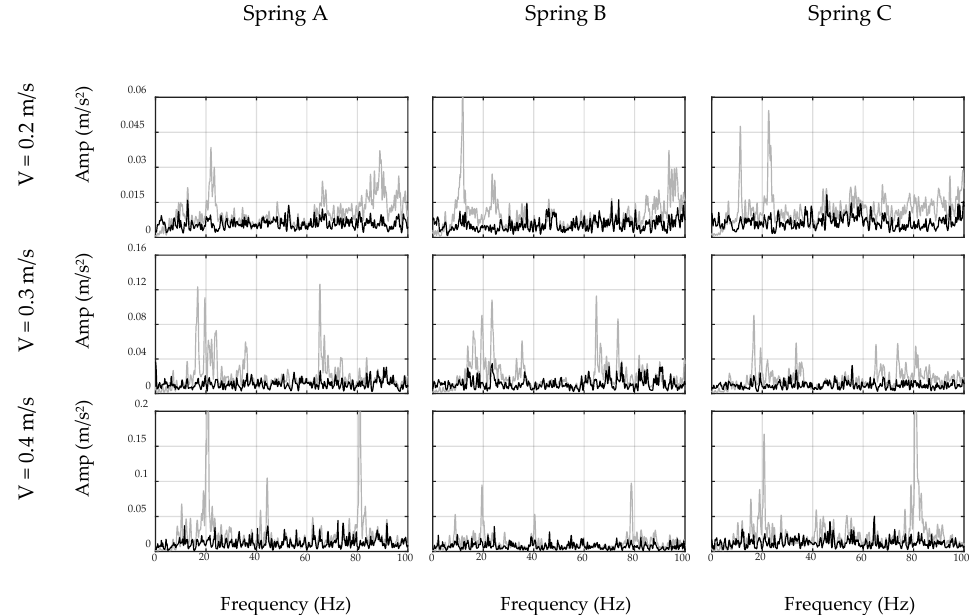
Spring A Spring B Spring C